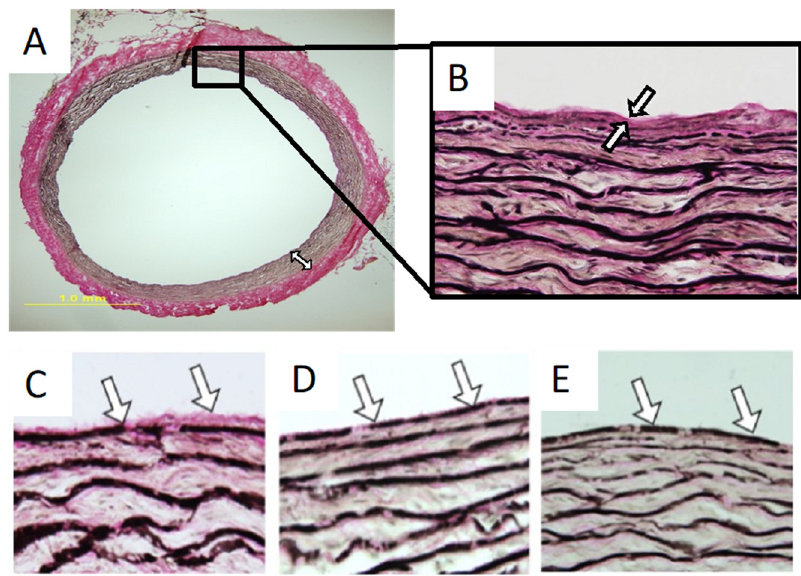
Figure 2. Preparation of arterial matrix scaffolds with a luminal elastic lamina surface. ( A , B ) Porcine mammary artery cross section ( A ) and close-up ( B ) showing collagen matrix (red) and abundant elastic laminae (black) in the arterial wall. The thin layer of native luminal surface collagen is identified by arrows. ( C – E ) Arterial matrix specimens processed by using high-viscosity acidic gels ( C , control gel; D , 2 h treatment in glycolic acid gel; E , 2 h treatment in lactic acid gel). These treatments can selectively remove the internal collagens while preserving the mural collagens. Additional work is required to optimize this approach.